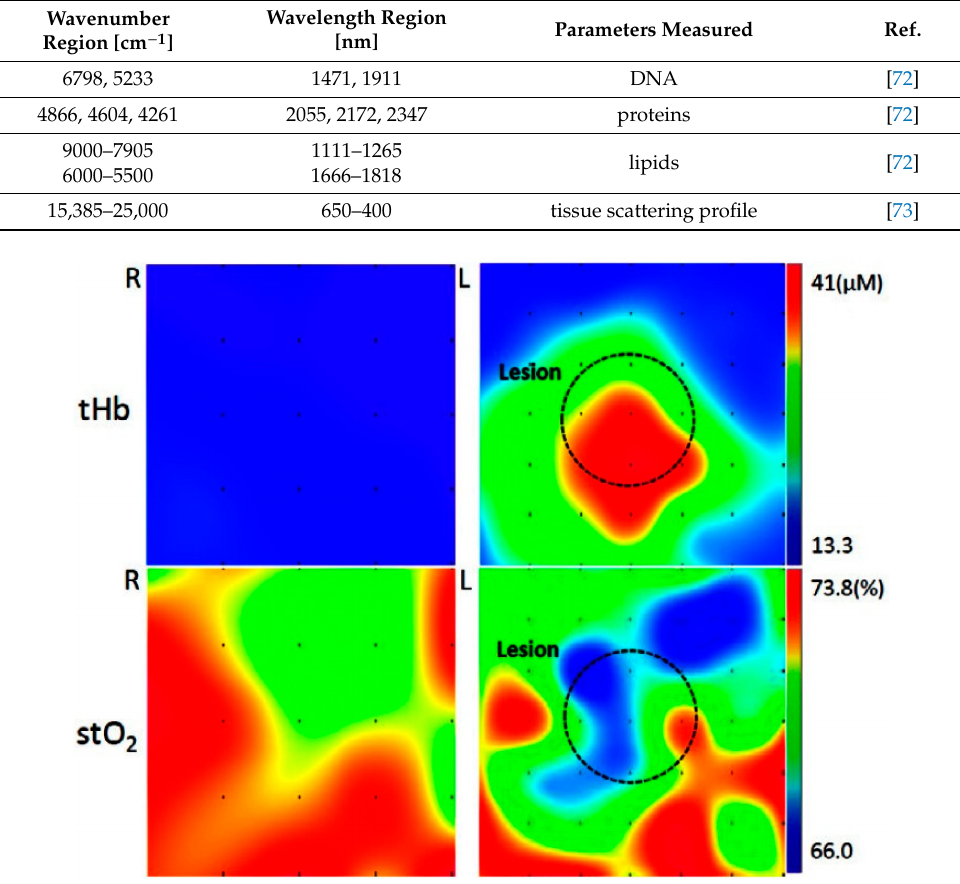
Figure 5. NIR image presenting the distribution of total hemoglobin (tHb) and tissue oxygen saturation (stO2) concentrations on both left and right breast acquired from a 56-year-old subject. Reproduced in compliance with CC BY license from Ref.